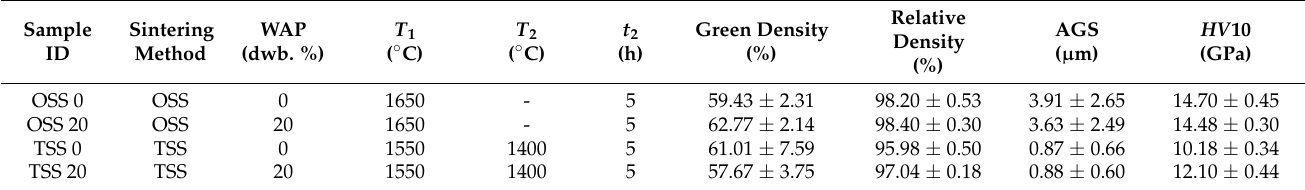
Table 5. Properties of alumina ceramics sintered conventionally and at determined favorable TSS conditions.